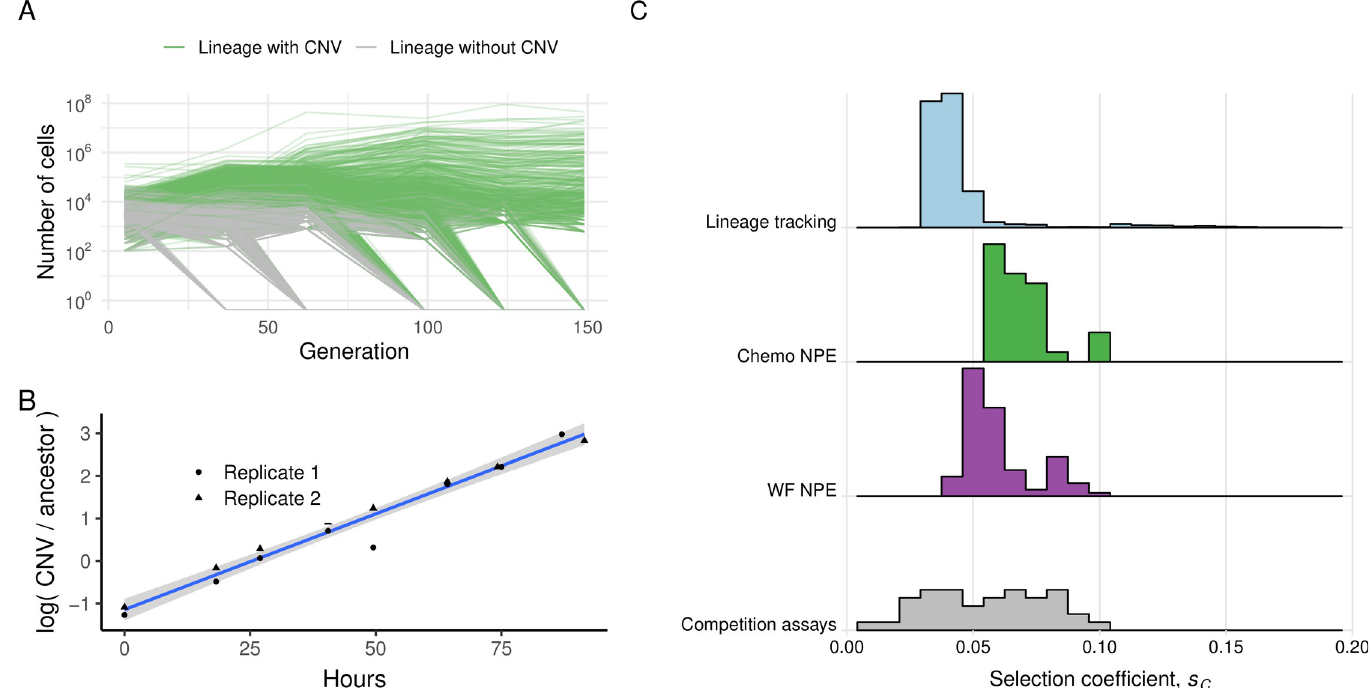
Fig 7. Comparison of DFE inferred using NPE, lineage-tracking barcodes, and competition assays. (A) Barcode-based lineage frequency trajectories in experimental population bc01. Lineages with (green) and without (gray) GAP1 CNVs are shown. (B) Two replicates of a pairwise competition assay for a single GAP1 CNV containing lineage isolated from an evolving population. The selection coefficient for the clone is estimated from the slope of the linear model (blue line) and 95% CI (gray). (C) The DFE for all beneficial GAP1 CNVs inferred from 11 populations using NPE and the WF (purple) and chemostat (Chemo; green) models compared with the DFE inferred from barcode frequency trajectories in the bc01 population (light blue) and the DFE inferred using pairwise competition assays with different GAP1 CNV containing clones (gray). Data and code required to generate this figure can be found at https://doi.org/10.17605/OSF.IO/E9D5X. CNV, copy number variant; DFE, distribution of fitness effects; NPE, Neural Posterior Estimation; WF,